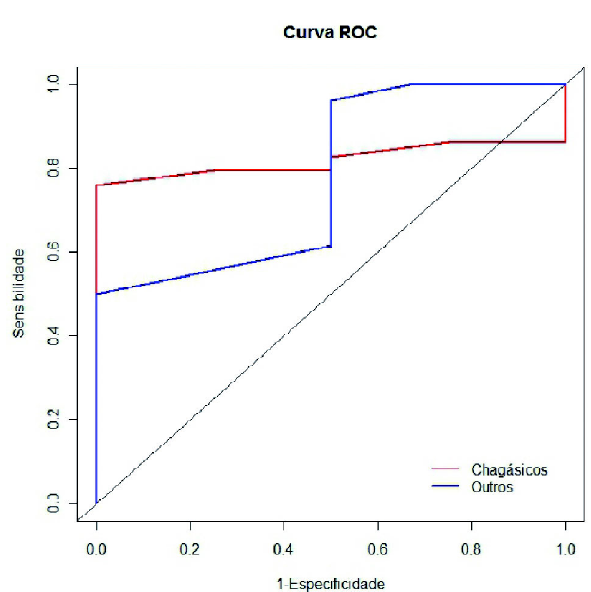
Fig. 2 - Curva ROC Sobreposta de pacientes chagásicos e não-